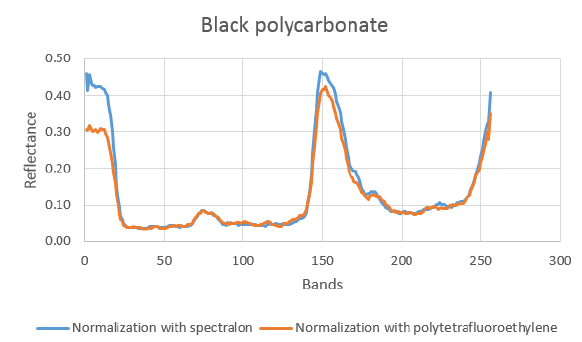
Figure 13. Comparison of the spectral signature of black polycarbonate with respect to spectralon and polytetrafluoroethylene